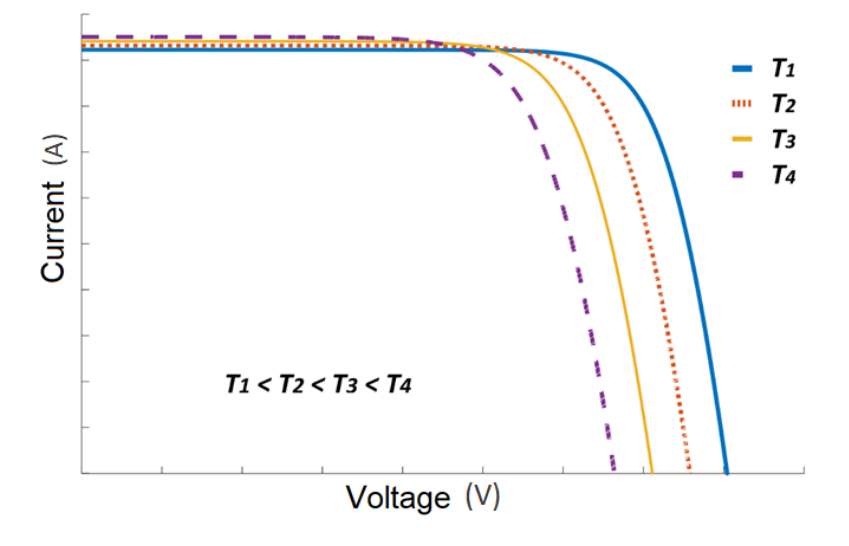
Figure 7. Effects of different operating temperature levels of the cell (T) on the I-V curve of the cell